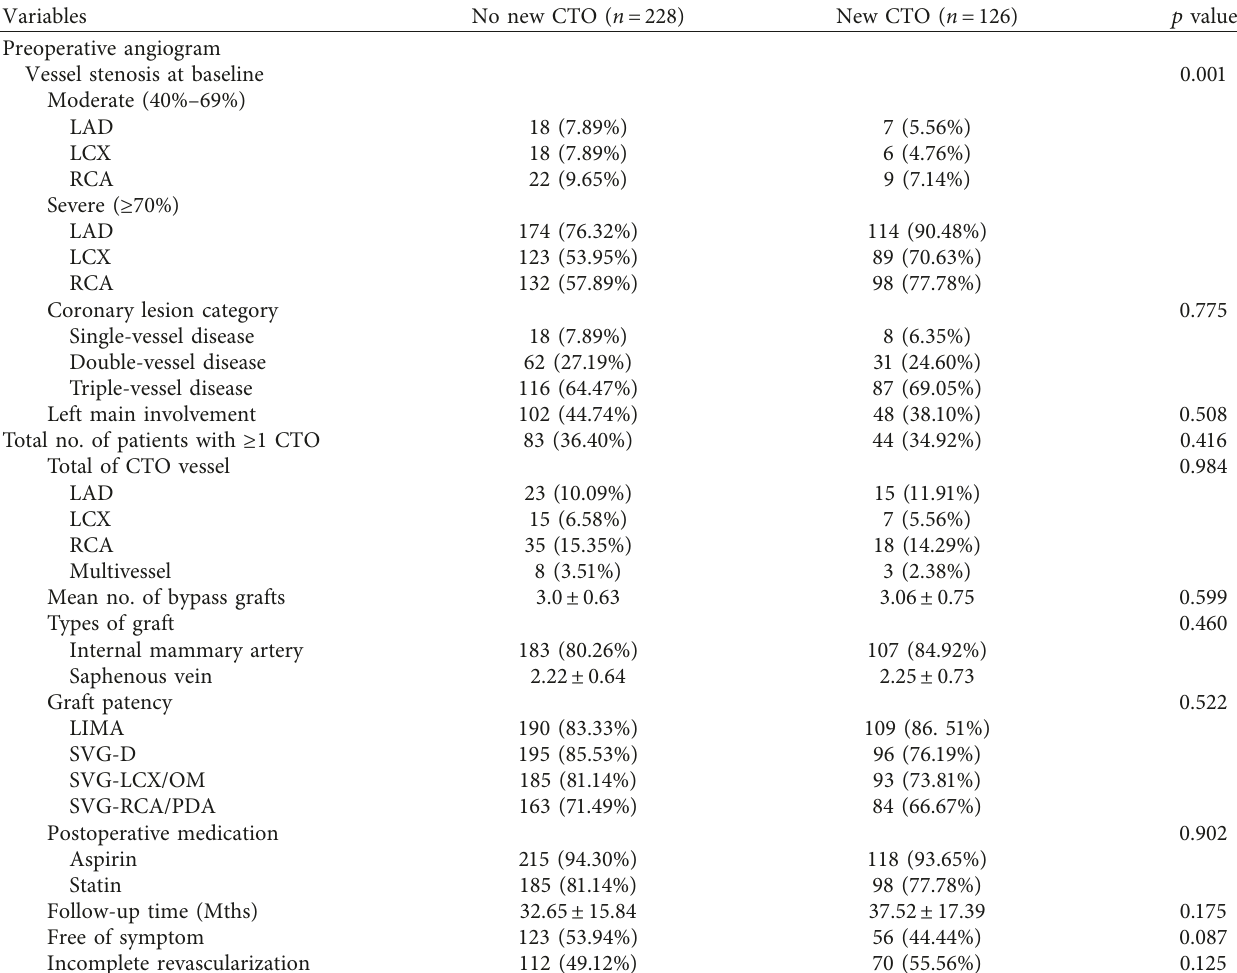
Table 2: Procedural and angiographic characteristics of patients with or without a new CTO.